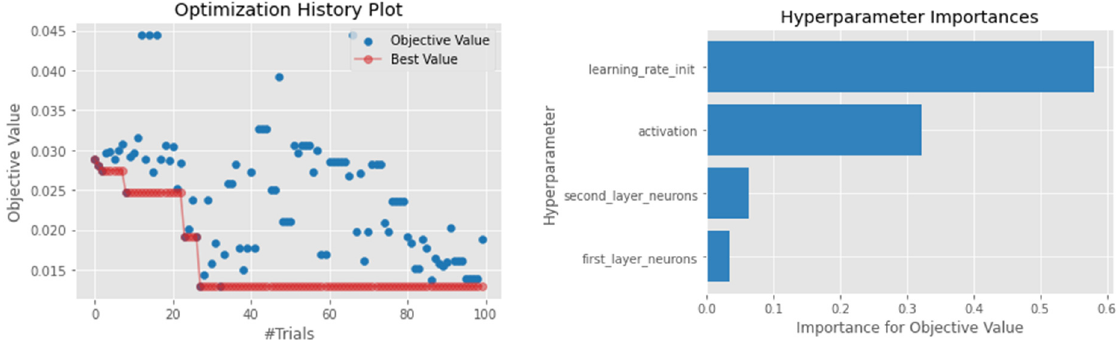
Figure 6. Hyperparameter optimization for the ANN model.